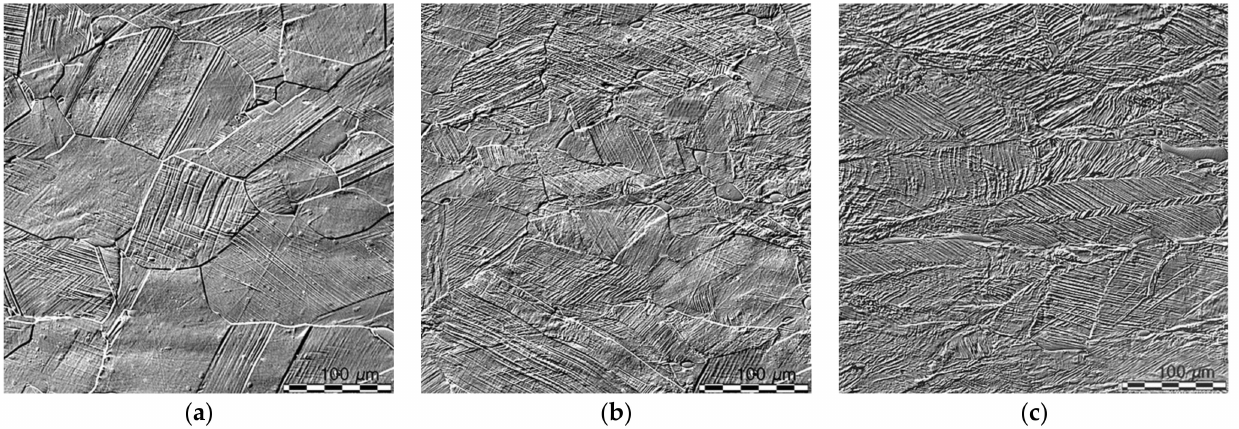
Figure 10. Microstructure of Fe-21.2Mn-2.73Al-2.99Si steel as observed by means of light microscopy in Nomarski contrast after selected deformation degrees; 10% ( a ), 20% ( b ) and 40% ( c